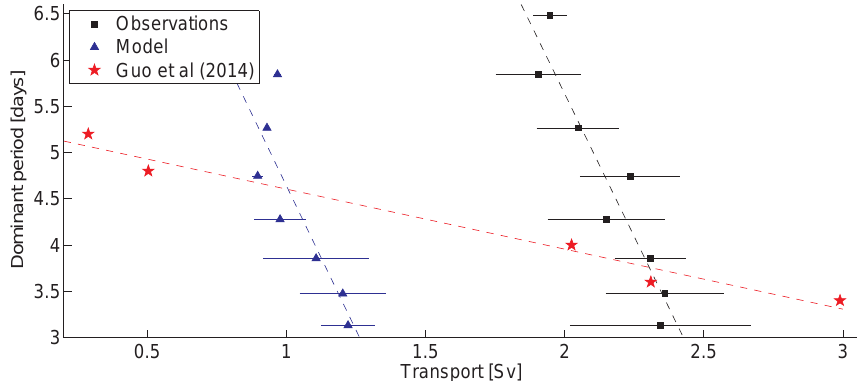
Figure 6. Mean transport across the sill averaged in time periods with different dominant oscillation periods approximately 80km down- stream of the sill. The dominant period is identified as the most energetic oscillation period for each time step in the wavelet analysis. The horizontal lines show the standard deviation and the dashed lines show the results from linear